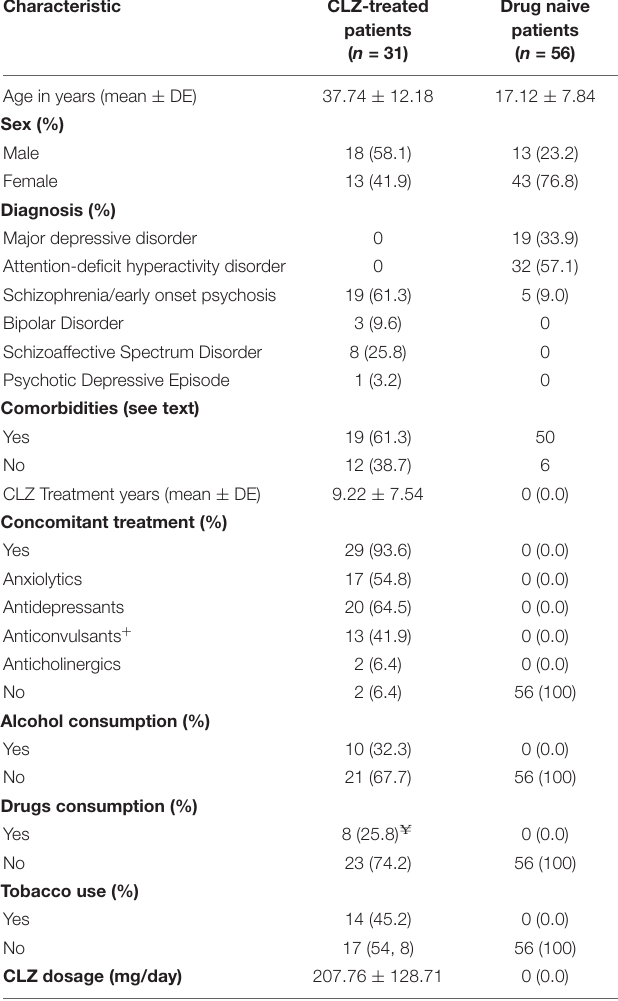
TABLE 1 | Clinical and demographic characteristics of all